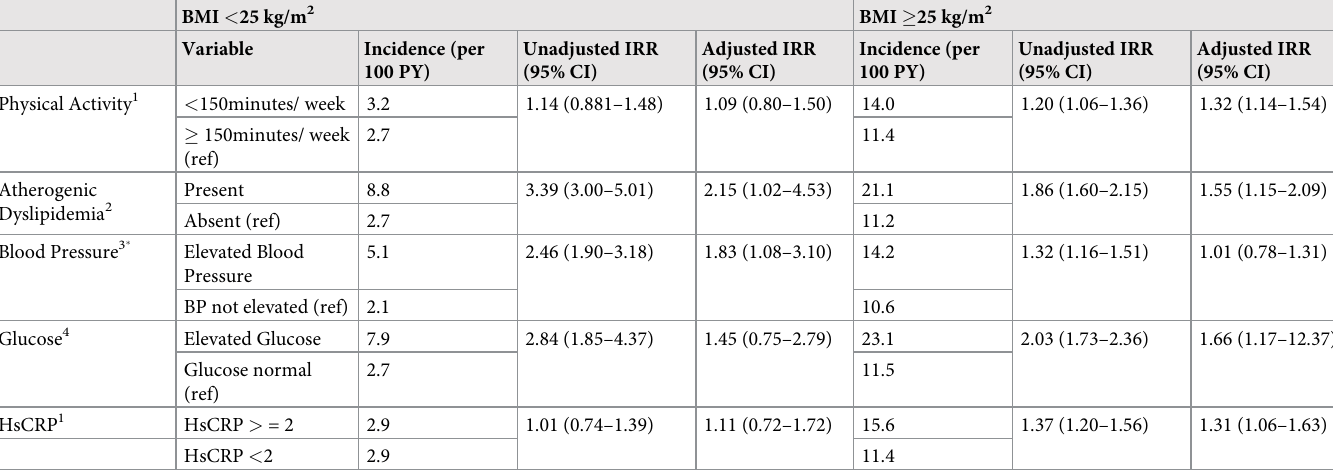
Table 4. Cardiometabolic disorders and the risk of NAFLD in lean and non-lean